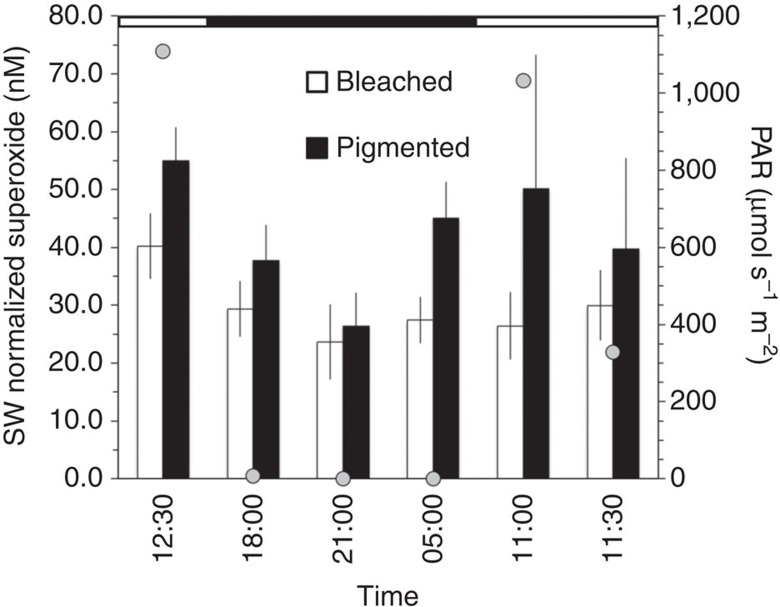
Diel variability in superoxide concentrations produced by
Porites compressa.To normalize coral-derived superoxide concentrations, superoxide levels in background seawater (SW) at 5–15 cm from the coral surface were subtracted. PAR values are indicated as grey circles. Periods of daylight (white) and darkness (black) are indicated in the horizontal scale at the top of the chart. Error bars indicate s.d. of the temporal signal collected at a rate of 0.5 points per second (n=21–124 points).